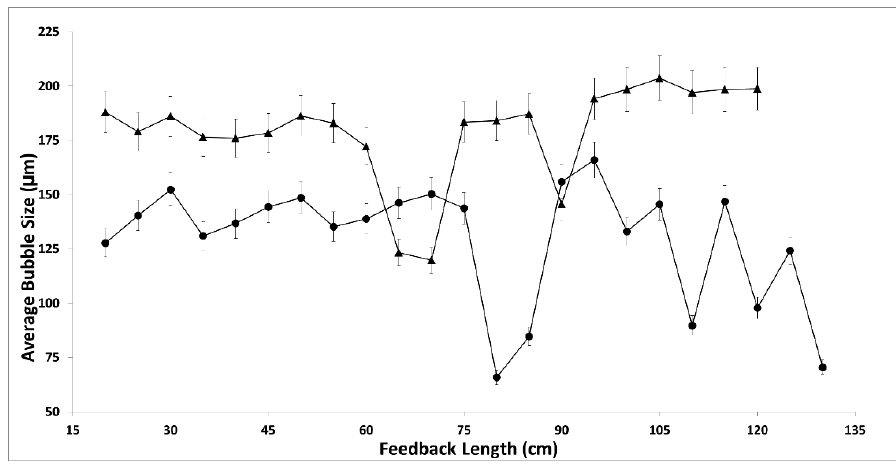
Energies 2018 , 11 , x 9 of 20